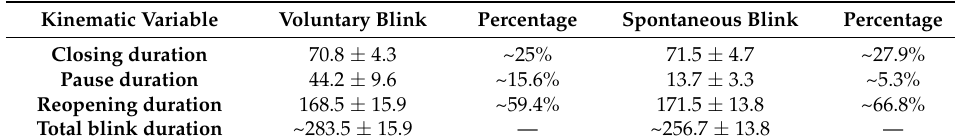
Table 2. Some of the blink kinematic variables: duration of each phase for voluntary and spontaneous blinks. The columns represent the percentage of each phase duration of the whole blink duration, which was roughly calculated for a better understanding of the different durations. The total blink duration was estimated by the summation of that of each phase (closing, pause and opening).